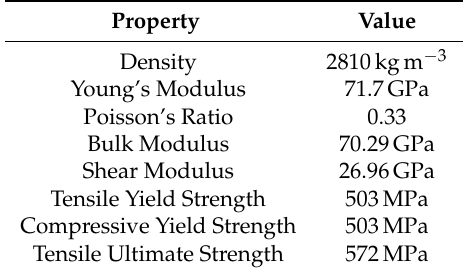
Table 1. Mechanical properties of Al-7075